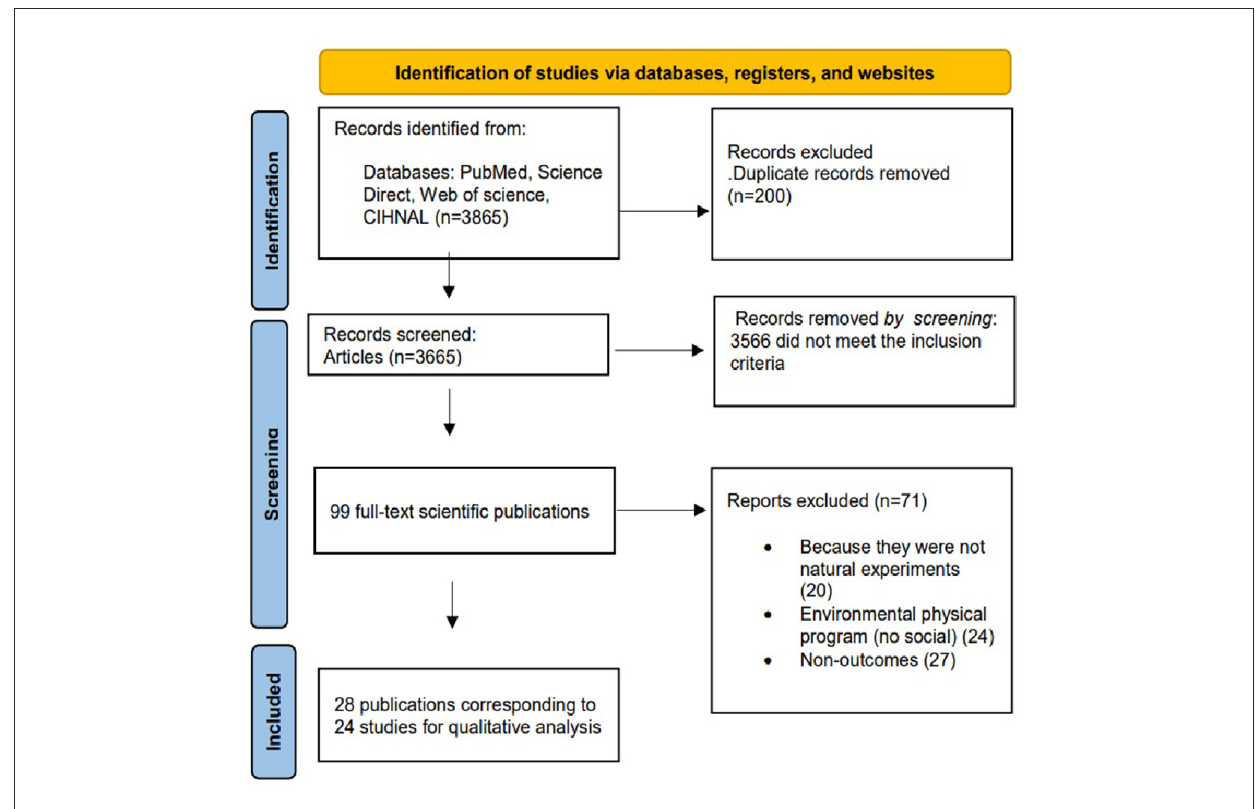
FIGURE2 Flowchart of the selection